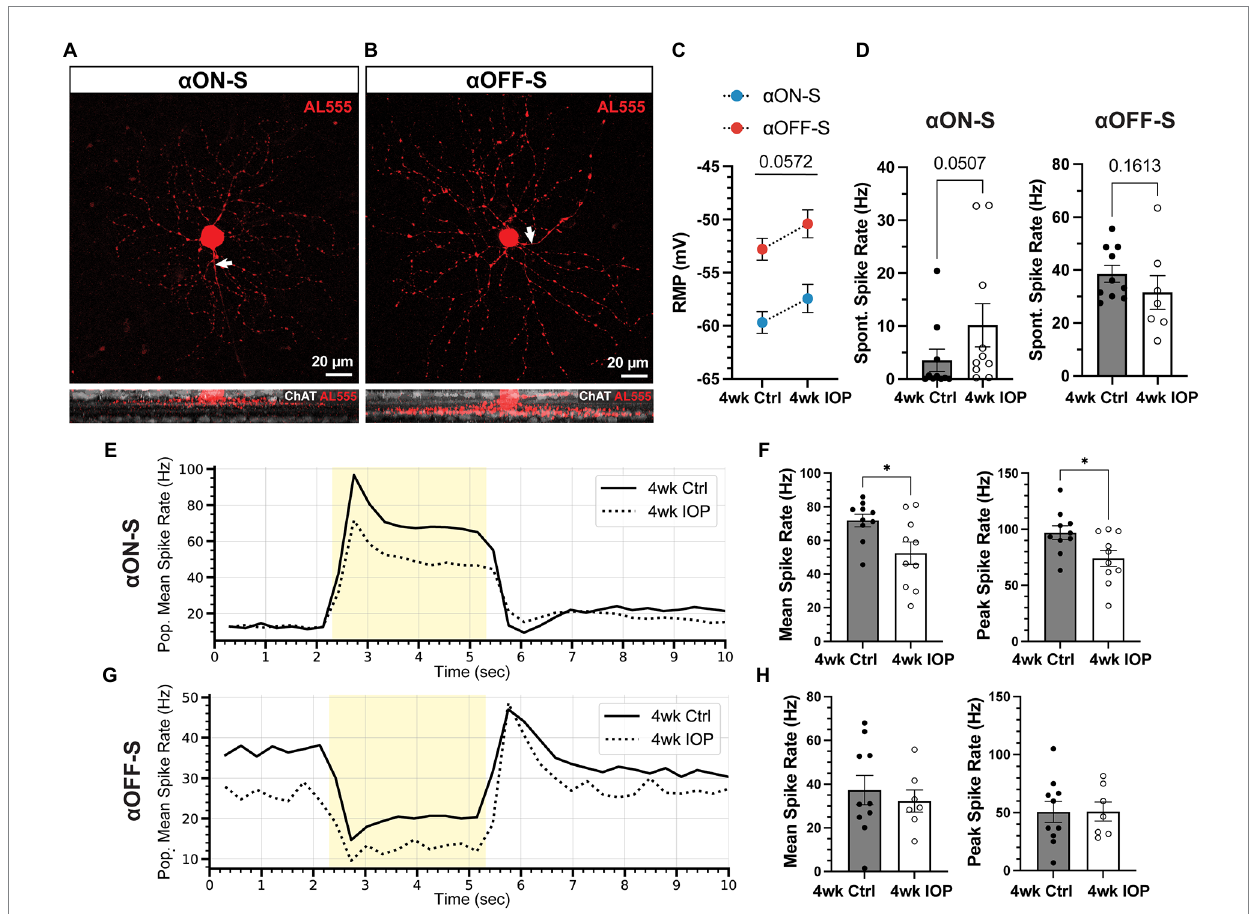
FIGURE 2 Elevated IOP alters membrane and light-evoked spiking characteristics in α ON-S and α OFF-S RGCs. (A,B) Morphologic and physiologic characterization of retinal ganglion cells (RGCs). Patched cells were filled with Alexa-fluor 555 dye (AL555, red) and morphologically reconstructed with confocal microscopy. Representative maximum intensity projections of alpha ON-sustained ( α ON-S, A ) and alpha OFF-sustained ( α OFF-S, B ) RGCs demonstrate characteristic soma size and dendritic branching patterns (upper). White arrows indicate the axonal projection. Orthogonal projections of representative AL555-filled cells co-labeled for choline acetyltransferase (ChAT, white) demonstrate the branching of α ON-S and α OFF-S dendrites in the ON- and OFF-sublaminas of the inner plexiform layer, respectively (lower). (C) Resting membrane potentials (RMP) for both cell types from 4wk Ctrl and IOP groups. RGC RMPs in the 4wk IOP group are more depolarized than controls ( p = 0.0572, 2-way ANOVA). (D) Spontaneous spiking rates for α ON-S and α OFF-S RGCs. α ON-S cells in the 4wk IOP group trend toward greater spontaneous spiking ( p = 0.0507, Mann–Whitney test), whereas 4wk IOP α OFF-S cells trend toward less spontaneous spiking ( p = 0.1613, Mann–Whitney test). (E) Mean firing rates of α ON-S cells in the 4wk Ctrl and 4wk IOP groups binned into 200 ms intervals during light stimulation (yellow). (F) Mean (left) and peak (right) light-evoked spike rates for α ON-S cells. 4wk IOP decreases both measures (mean: p = 0.0202, unpaired t -test; peak: p = 0.0251, unpaired t -test). (G) Mean firing rates of α OFF-S cells in the 4wk Ctrl and 4wk IOP groups binned into 200 ms intervals during light stimulation (yellow). (H) Mean (left) and peak (right) light-evoked spike rates for α OFF-S cells. Error bars: ± standard error of the mean. * p <